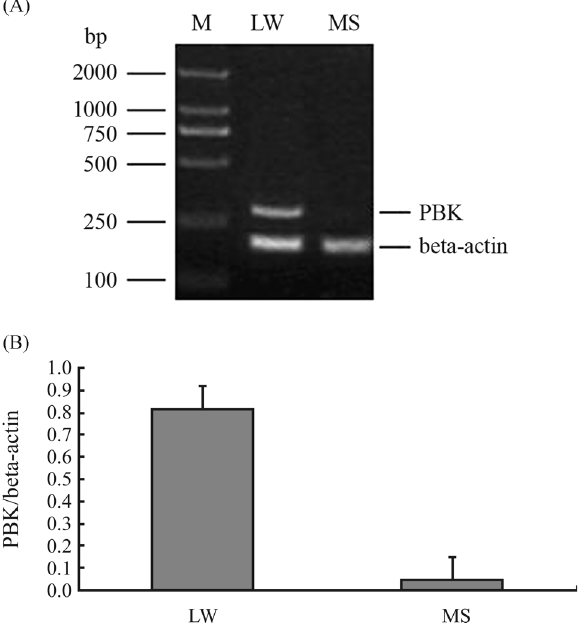
Figure2 -Semi-quantitativeRT-PCRidentificationofGene10(PBK)ex- pression. (A) RT-PCR analysis of Gene 10 (PBK) on a 1% agarose gel stainedwithethidiumbromide;(B)PBKmRNAexpressionlevelsrelative to beta-actin; error bars indicate standard deviations (n = 5). M-DL2000 DNA marker; LW – Large White; MS – Meishan.